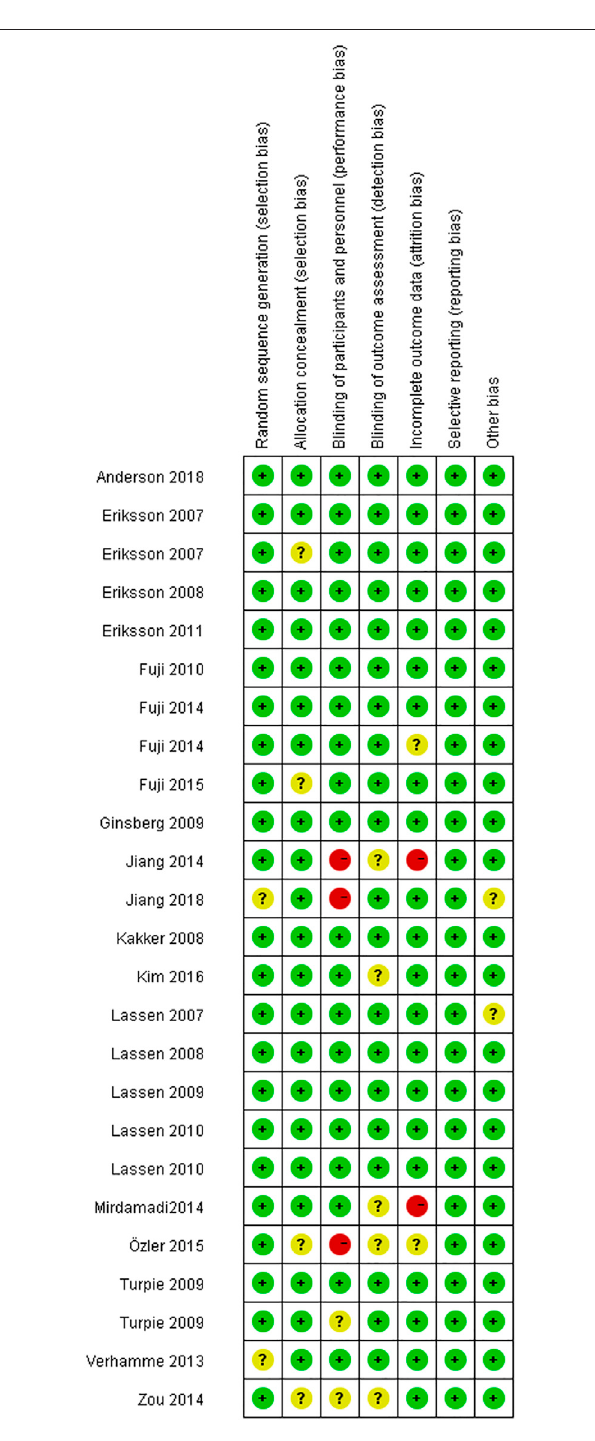
FIGURE 2 | Risk of bias